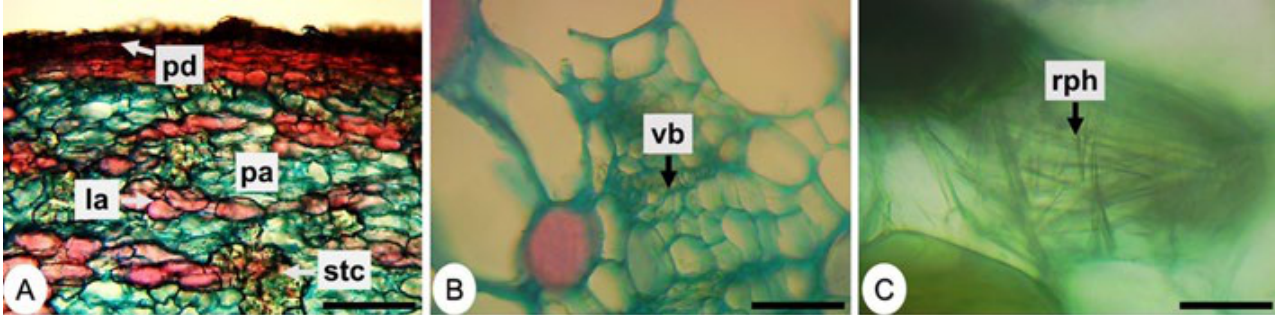
FIGURE 5 - Cross-sections of the fruit of Manilkara zapota (L.) P.Royen (Sapotaceae). A, B: general organization of the structures. C: detail of raphides. Abbreviations: la = laticifer; pa = parenchyma; pd = periderm; rph = raphide; stc = stone cell; vb = vascular bundle. Bars: A = 200 µm; B, C = 20